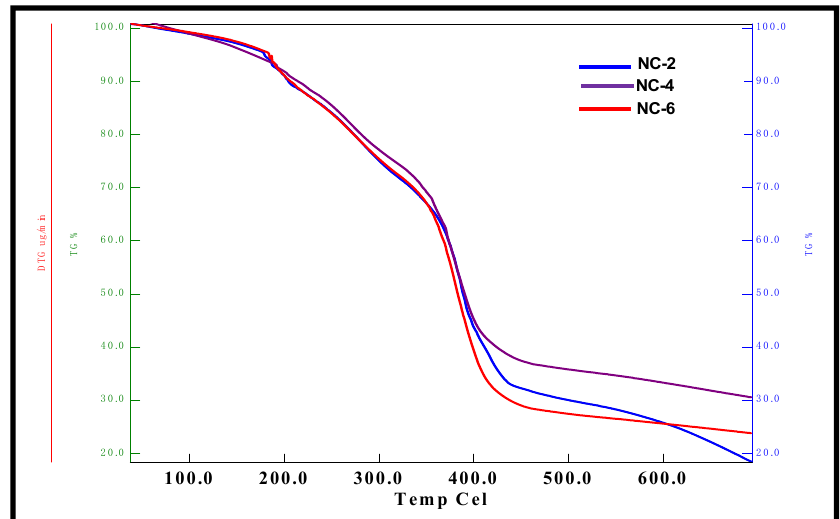
Figure 7. TGA micrographs of NC ‐ 2, NC ‐ 4, and NC ‐ 6 NCHs.